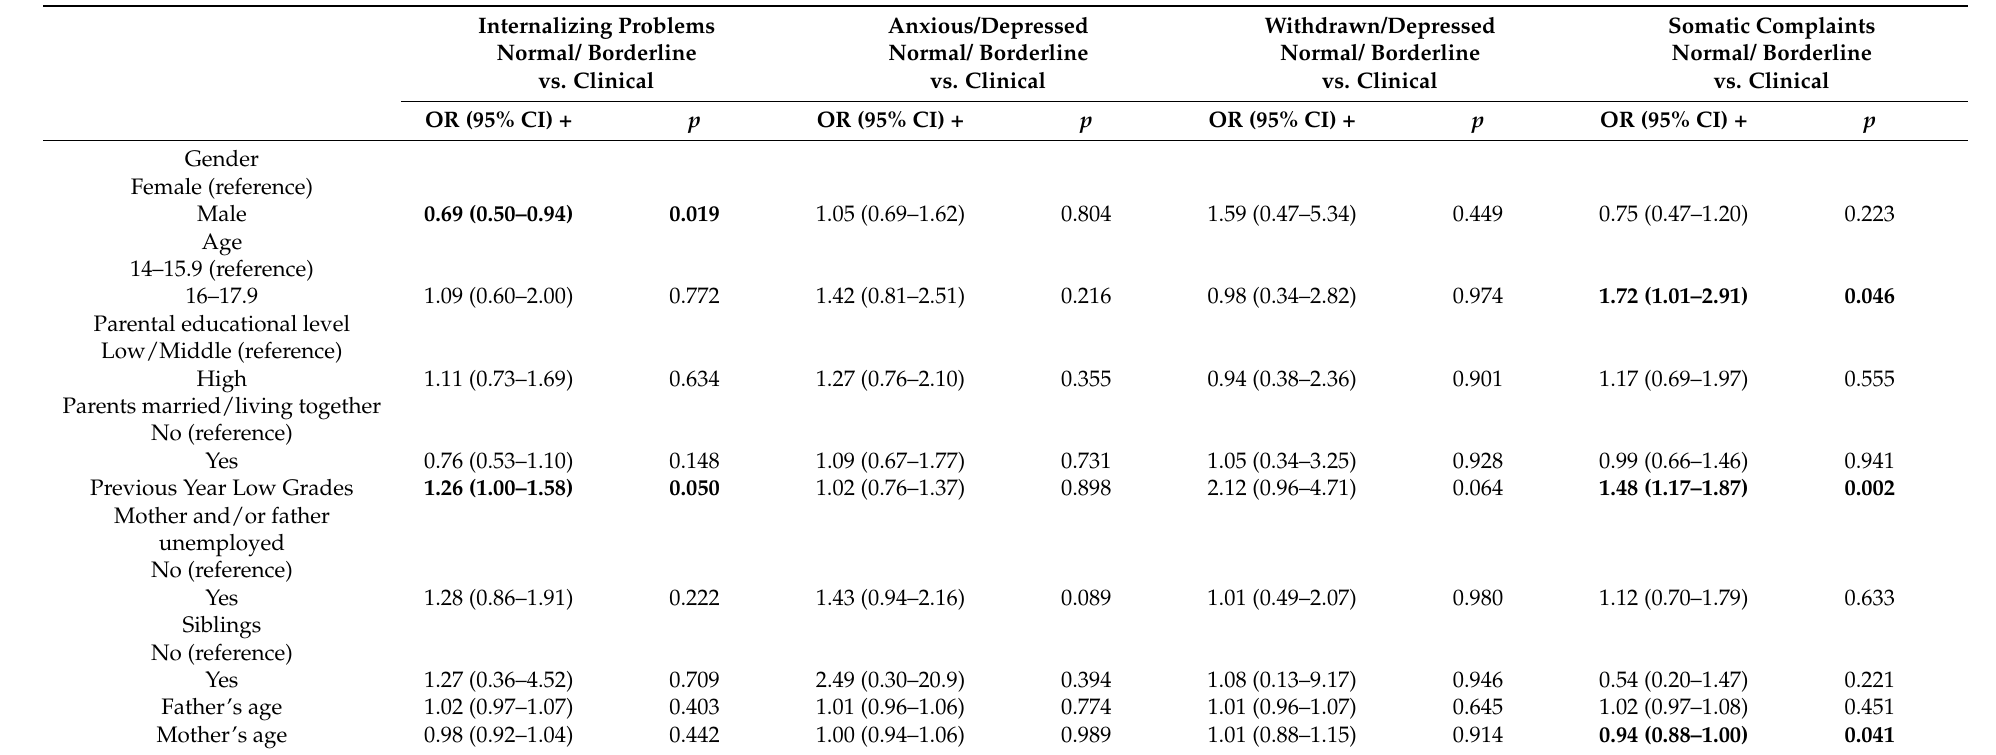
Table 5. Results from multiple logistic regression analysis with clinical internalizing problems (in all subscales and in total) as the dependent variable for Iceland . Bold cells denote statistically significant